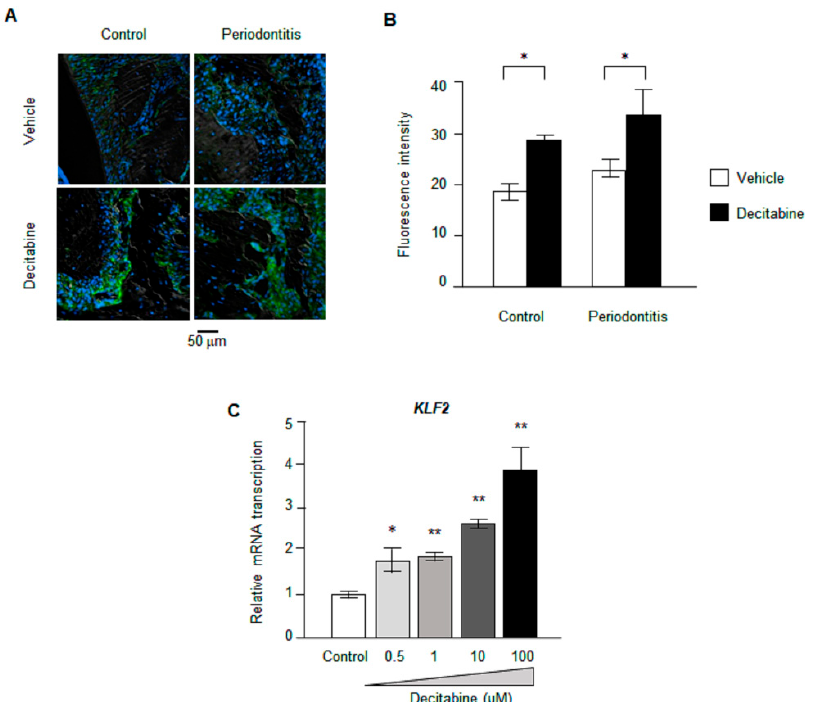
Figure 4. Effects of decitabine on Krüppel-like factor-2 (KLF2) expression in vitro and in vivo. ( A ) Representative immunofluorescence images showing the expression of KLF2 protein. The tissues were immunostained for KLF2 (green), and nuclei were counterstained with 4 ′ ,6-diamidino-2- phenylindole (DAPI) (blue). Magnification: × 200. ( B ) Averaged data for the fluorescence intensity of KLF2 immunostaining (i.e., KLF2 protein expression) in each group. * p < 0.05 vs. corresponding vehicle group. ( C ) KLF2 mRNA expression in vitro measured by real-time PCR. The mRNA level was normalized to the mean control value. * p < 0.05, ** p < 0.01 vs. control.